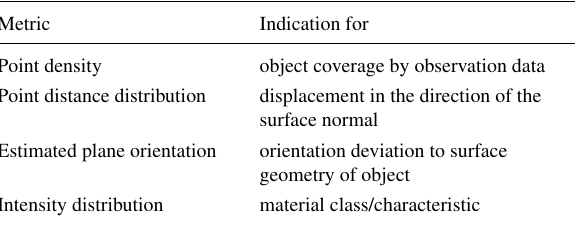
Table 1. List of implemented metrics to assess the matching between point cloud and city